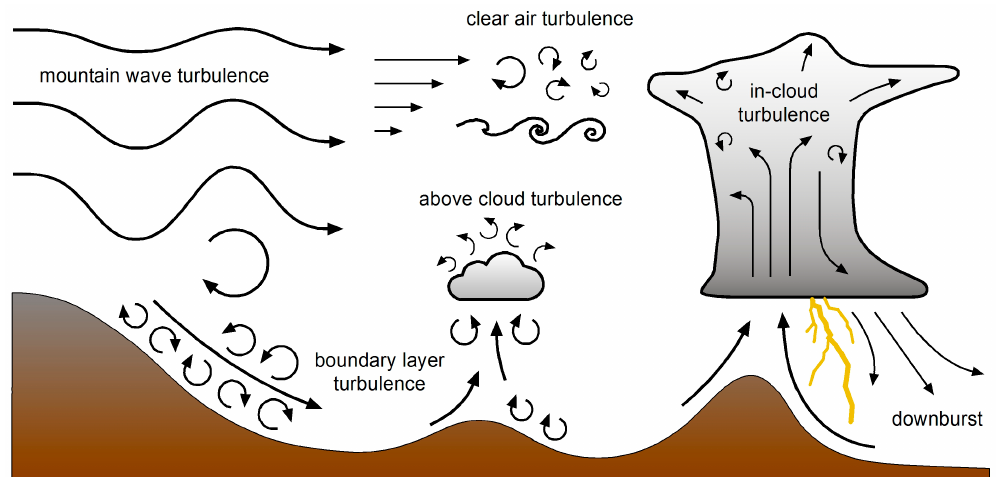
Figure 7. Some turbulence features over and near mountainous terrain relevant for aviation (adapted from [103]).